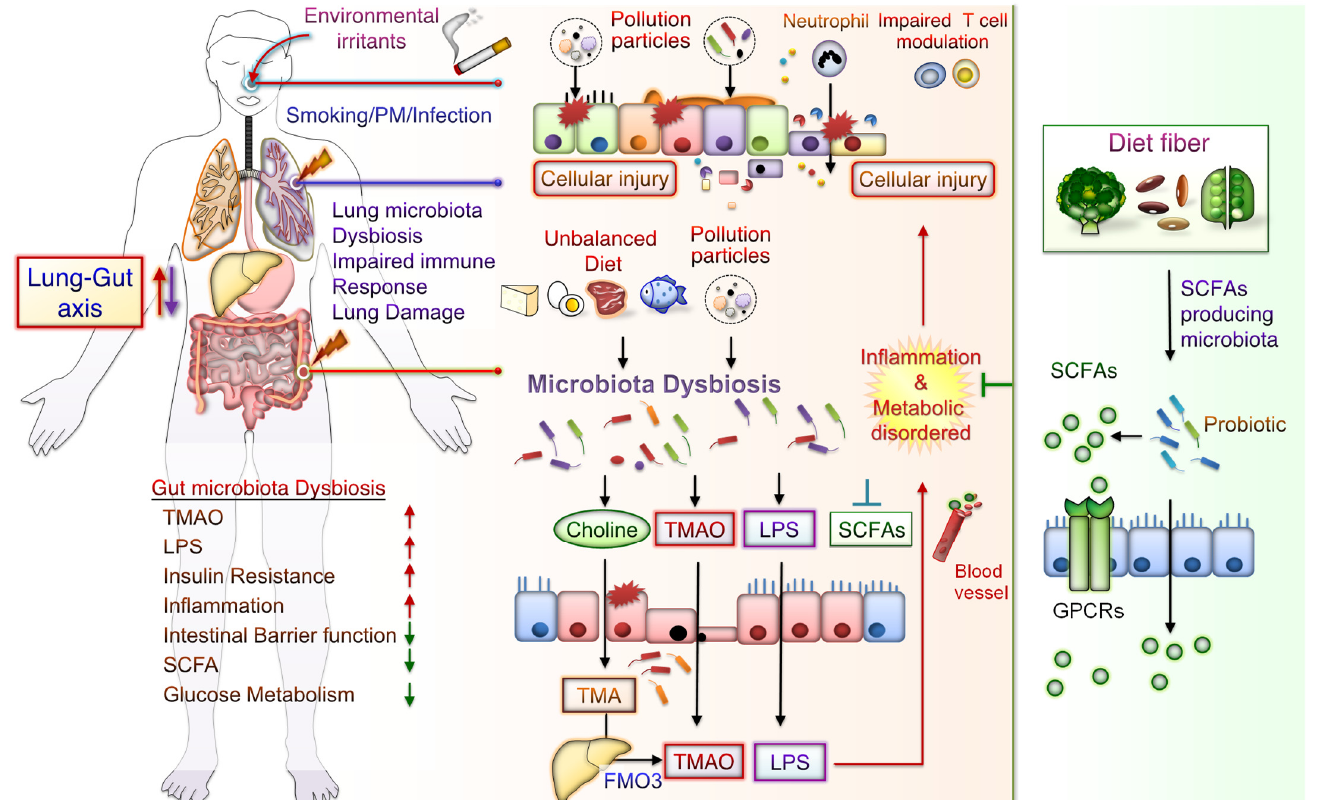
Figure 1. Potential Effects of CS or PM exposure on the lung–gut axis, leading to aggravating systemic inflammation and metabolic disorders. Cigarette smoking (CS) and ambient particulate matter (PM) are critical factors mediating gut microbiota dysbiosis and changes in microbiota-derived metabolites. Microbiota endotoxins and metabolites, such as lipopolysaccharide (LPS), metabolite trimethylamine (TMA), N-oxide (TMAO), and short-chain fatty acid (SCFA), participate in the regulation of system inflammation, which influences lung function. CS or PM inhalation leads to gut microbiota dysbiosis. Gut dysbiosis may, in turn, increase the levels of TMA—which is then converted to TMAO by the liver enzyme flavin-containing monooxygenase 3 (FMO3). Dietary fiber fermentation by distinct SCFA-associated gut microbiota leads to SCFA generation. Activation of SCFA/G-protein-coupled receptor (GPCR) signaling is crucial for maintaining gut barrier function and inhibiting inflammation. Thus, targeting the lung–gut axis may prevent systemic inflammation and metabolic disease.